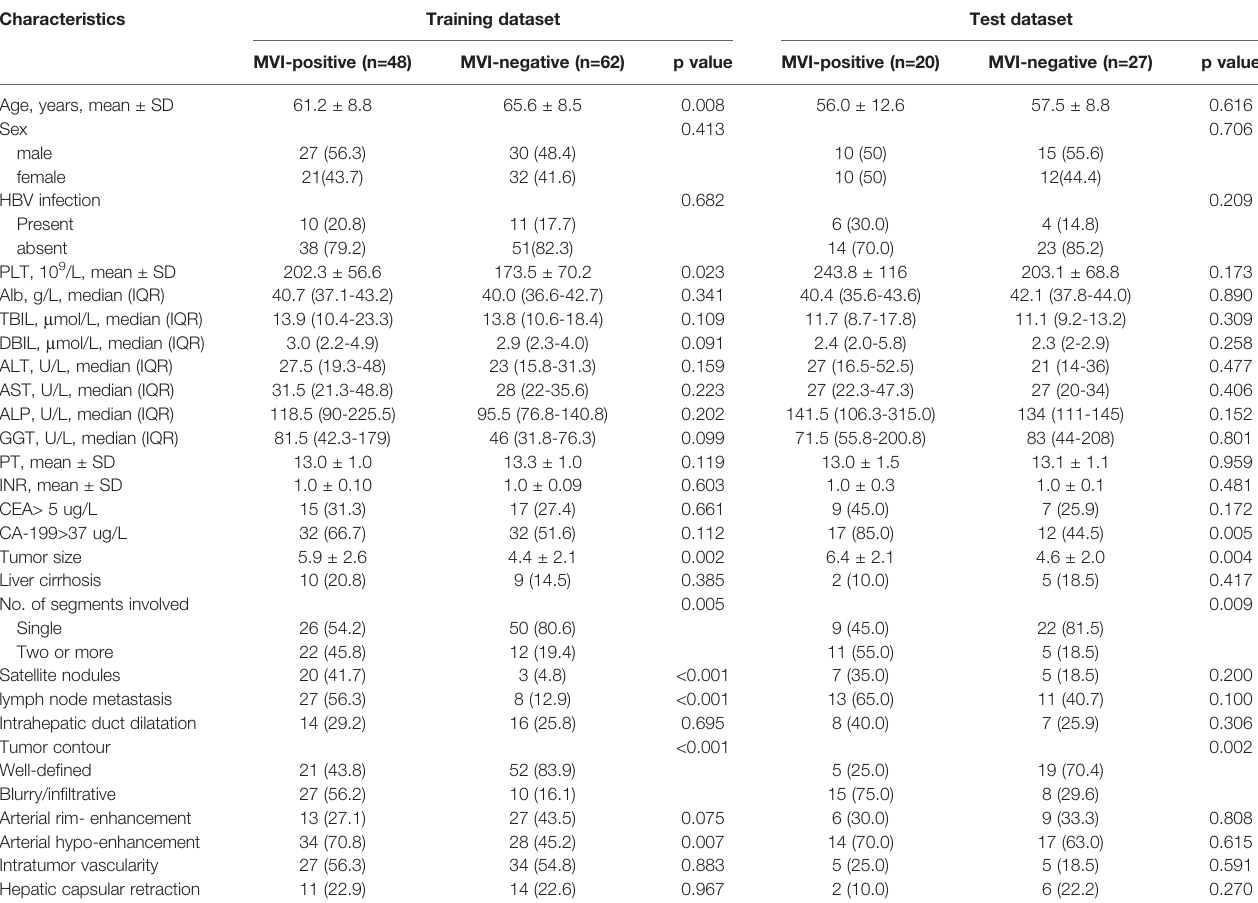
TABLE 1 | Baseline characteristics of patients.